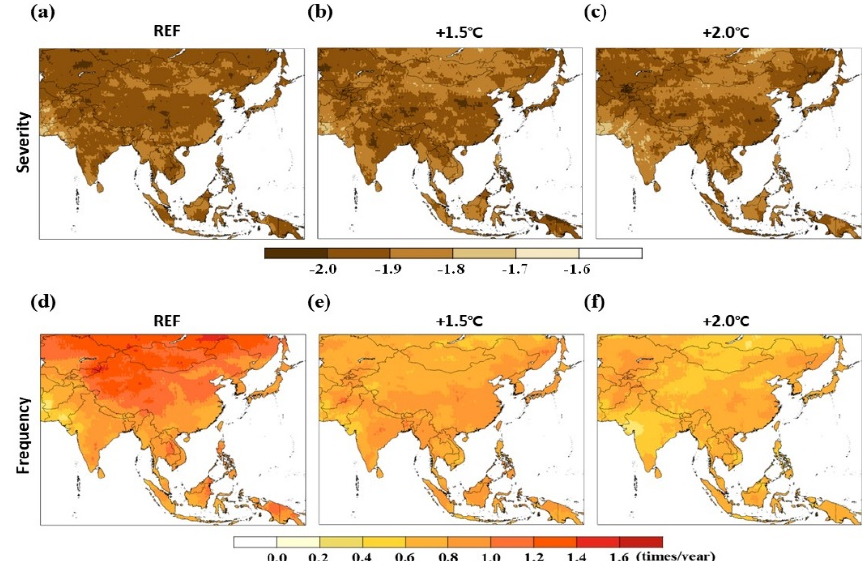
Figure 6. Spatial distribution of annual mean ( a – c ) value of severe (extreme) drought; ( d – f ) frequency of severe drought (unit: times / year) based on standardized precipitation index (SPI) under 1.5 and 2.0 °C global warming compared to the reference period (REF) in the Asian monsoon region.